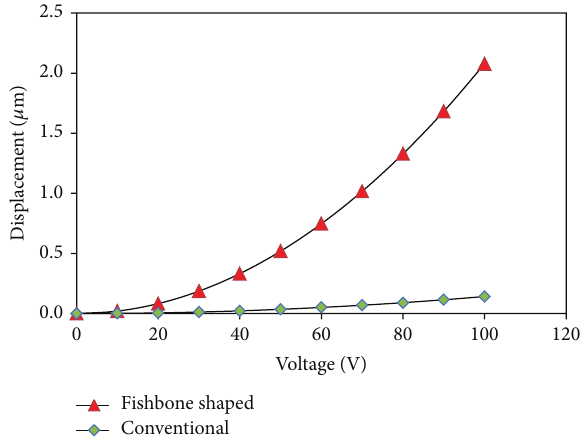
Figure9:Drivingvoltageversusdisplacementofthecombfingersin the 𝑥 -direction for single unit of straight conventional comb finger and fishbone shaped comb driver.